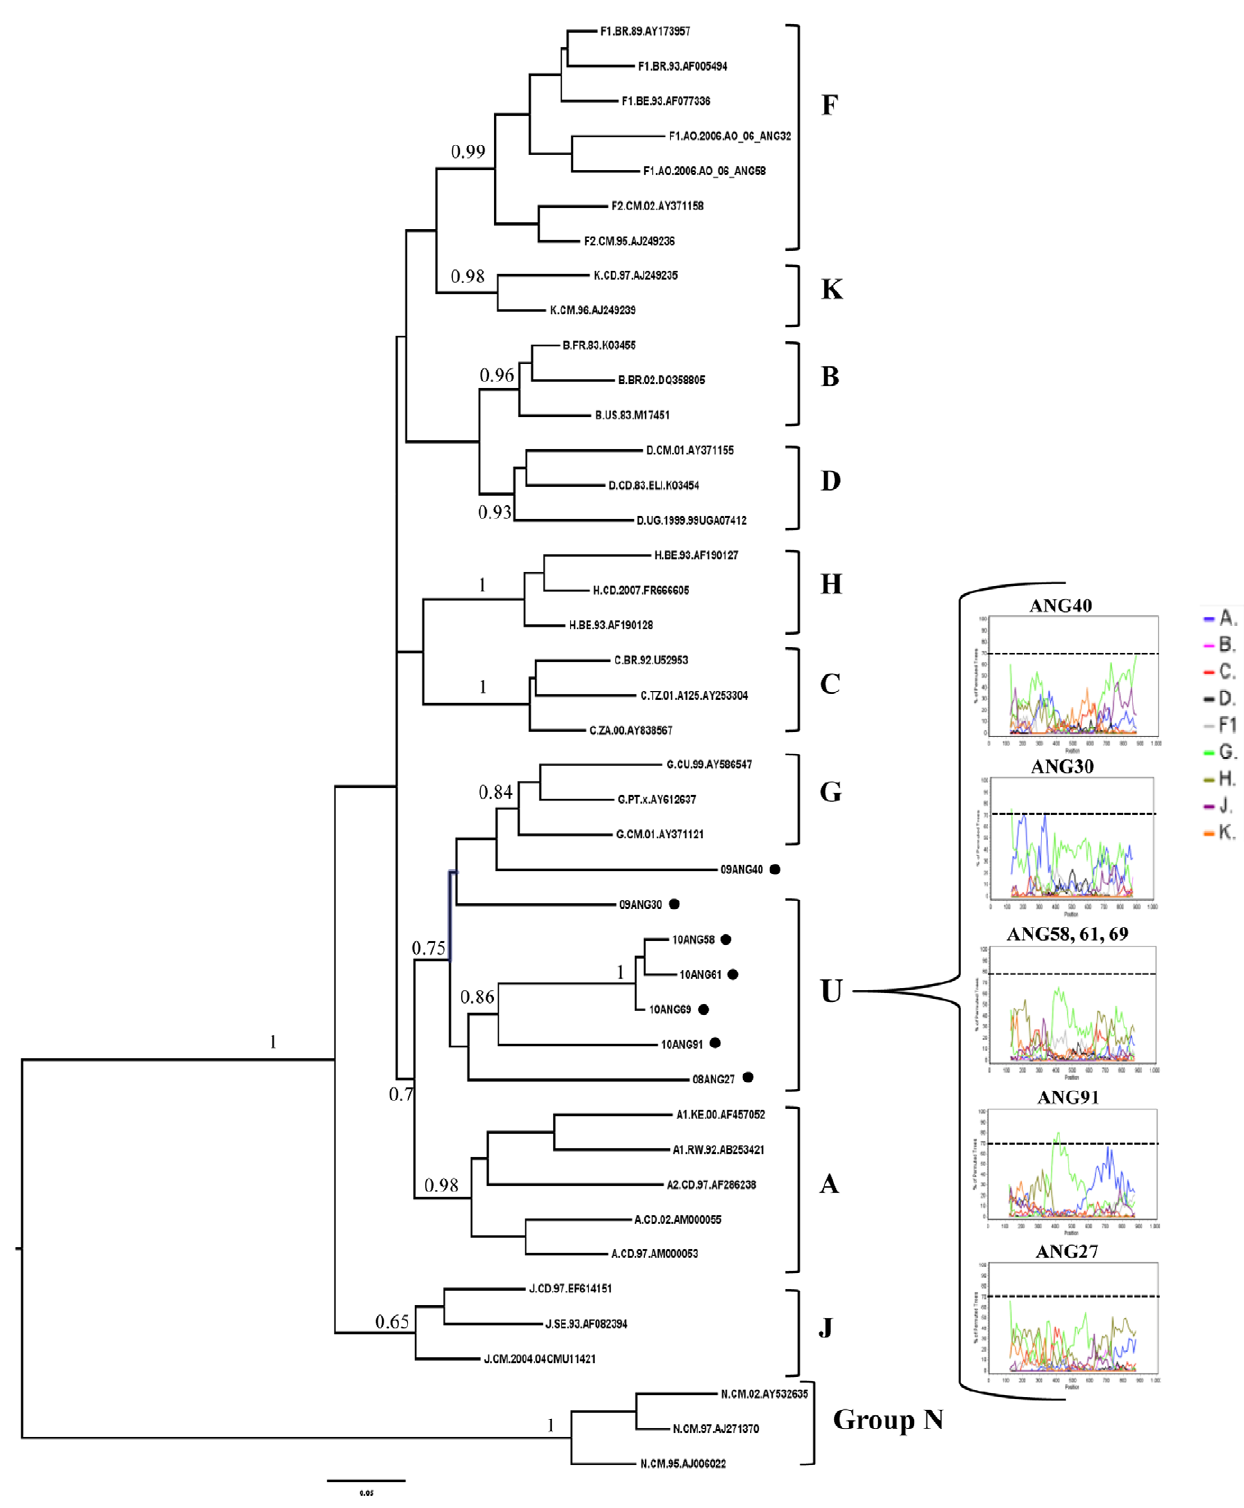
Figure 4. B. ML tree of the pol (PR/RT) region of Angolan sequences classified as U (black circles) plus reference sequences from all HIV-1 subtypes. aLRT values are only shown at key notes. The scale represents number of substitutions per site. Bootscanning plots of Angolan U strains are shown. Only one representative bootscanning plot is shown for the phylogenetically related Angolan U sequences ANG58, ANG61 and ANG69. The dashed line indicates the cut-off of 70%.